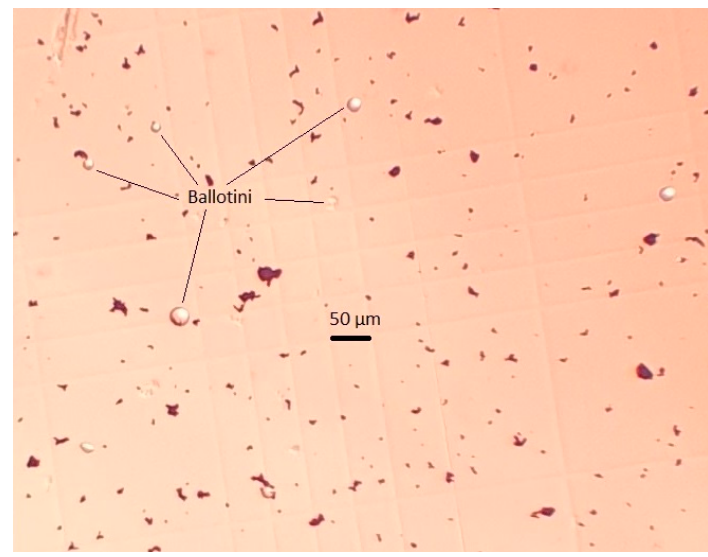
Figure 1. Micrograph of magnetite (black objects) and Ballotini (light balls) particle mixture.